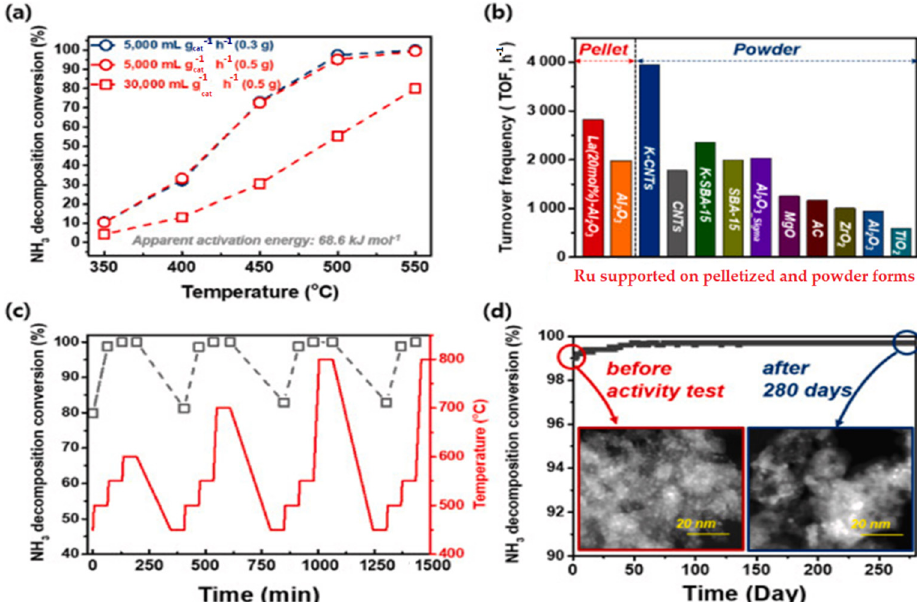
Figure 32. Catalytic activities of Ru/La Al 2 O 3 under different GHSVs with varying catalyst loadings ( a ); TOF comparisons of various Ru supported on pelletized and powder forms ( b ); catalytic activities with varying temperatures ( c ); TEM images of durability tests of the catalyst over 280 days (6700 h) ( d ). Reprinted with permission [48].